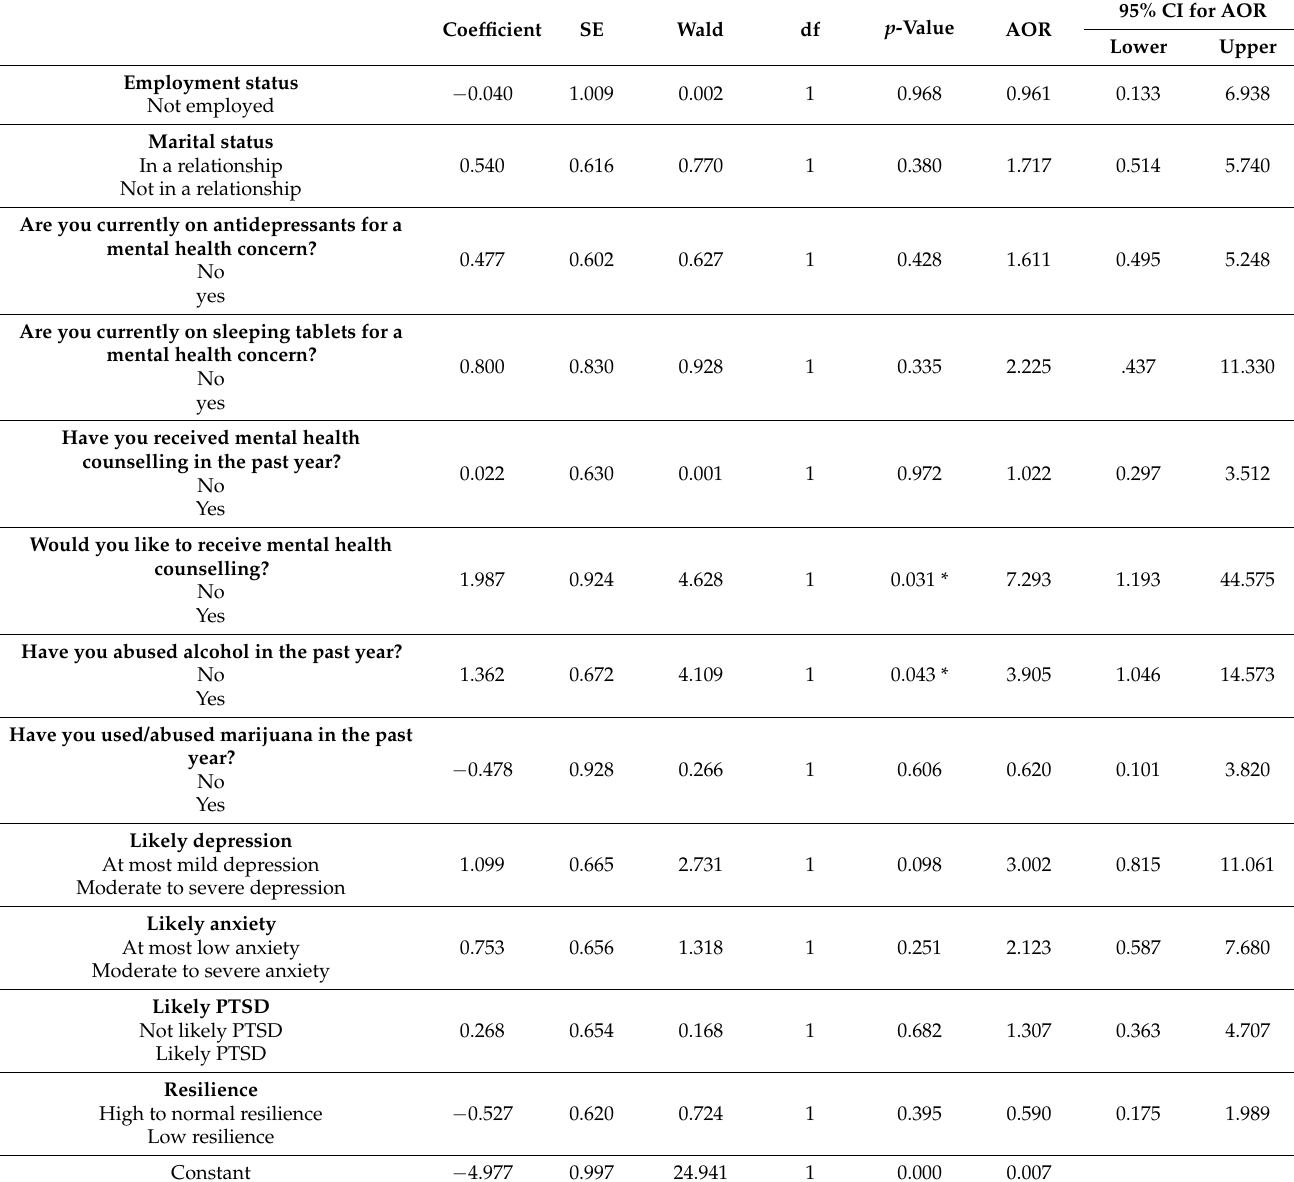
Table 3. Logistic regression model for respondents’ likelihood to present with passive death wishes or thoughts of self-harm. Coefficient SE